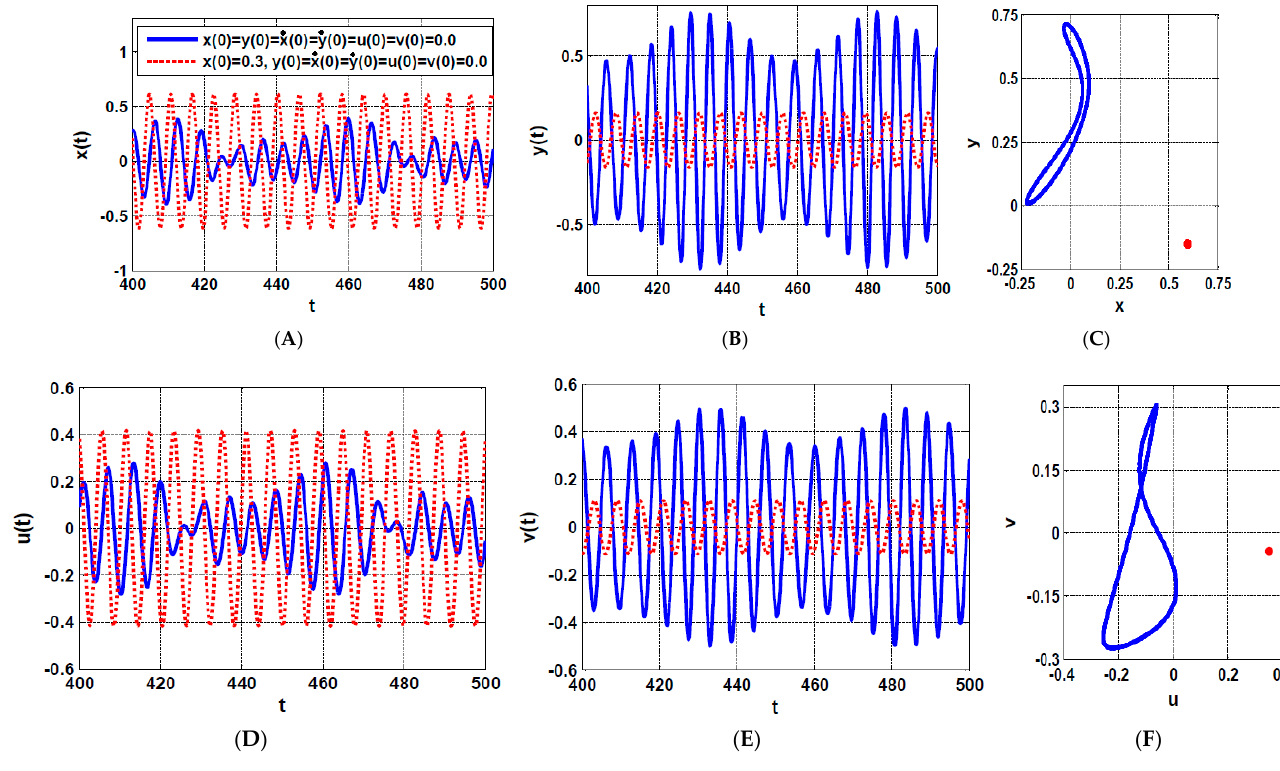
Figure 11. The rotor system steady-state time-response according to the point p (cid:2869) shown in Figure 10B (i.e., when 𝑓 = 0.075 , 𝜂 (cid:2869) 𝜂 (cid:2871) = 0.05,𝜂 (cid:2870) 𝜂 (cid:2872) = 0 ): ( A – C ) temporal oscillation in 𝑋 and 𝑌 direc- tions and the corresponding Poincaré map, respectively, ( D – F ) temporal oscillations of the U-IRC and V-IRC and the corresponding Poincaré map, respectively.